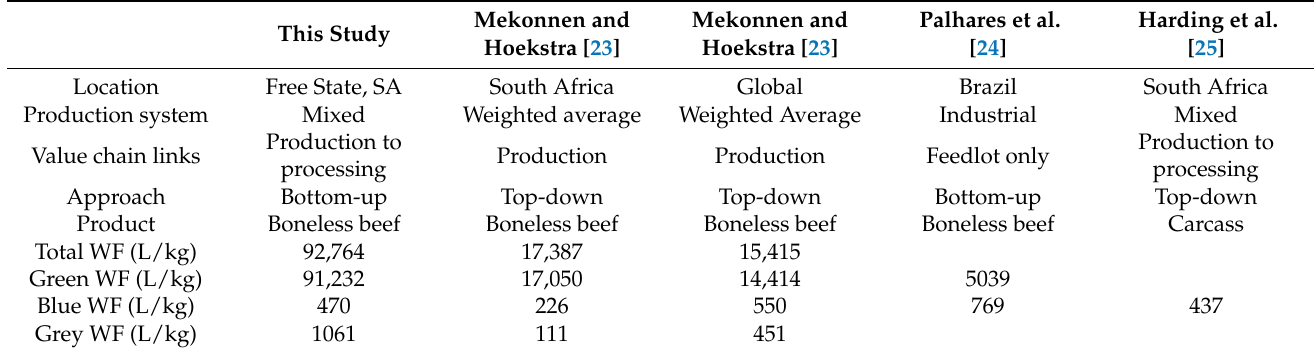
Table 5. Comparison of results with other